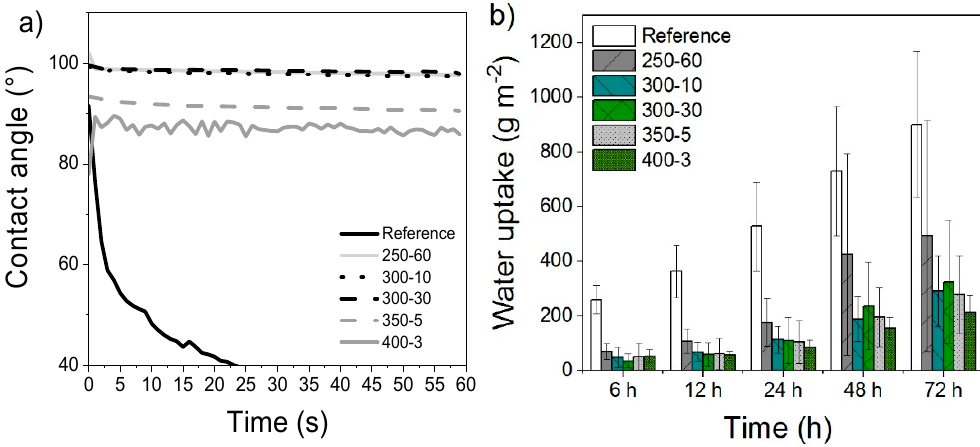
Figure 3. ( a ) Wettability measured by contact angle during a measurement period of 60 s and ( b ) absorption (g m − 2 ) of samples measured by 0–72 h water floating. The vertical scale on 3a has been shortened and the standard deviation omitted to better highlight individual differences between modified samples. The figure including standard deviations is presented in Supplementary Figure S1.